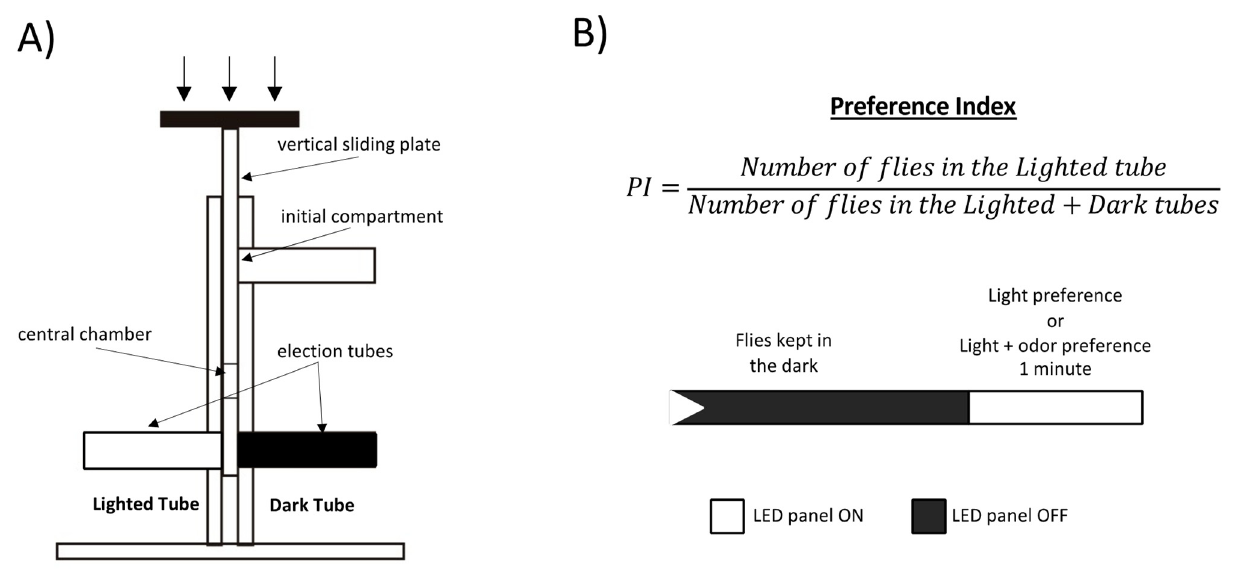
Figure 2. Light attraction setup. ( A ) Schematic representation of the modified T-maze. ( B ) Preference Index formula (top) and illumination conditions used in the light attraction test (bottom).